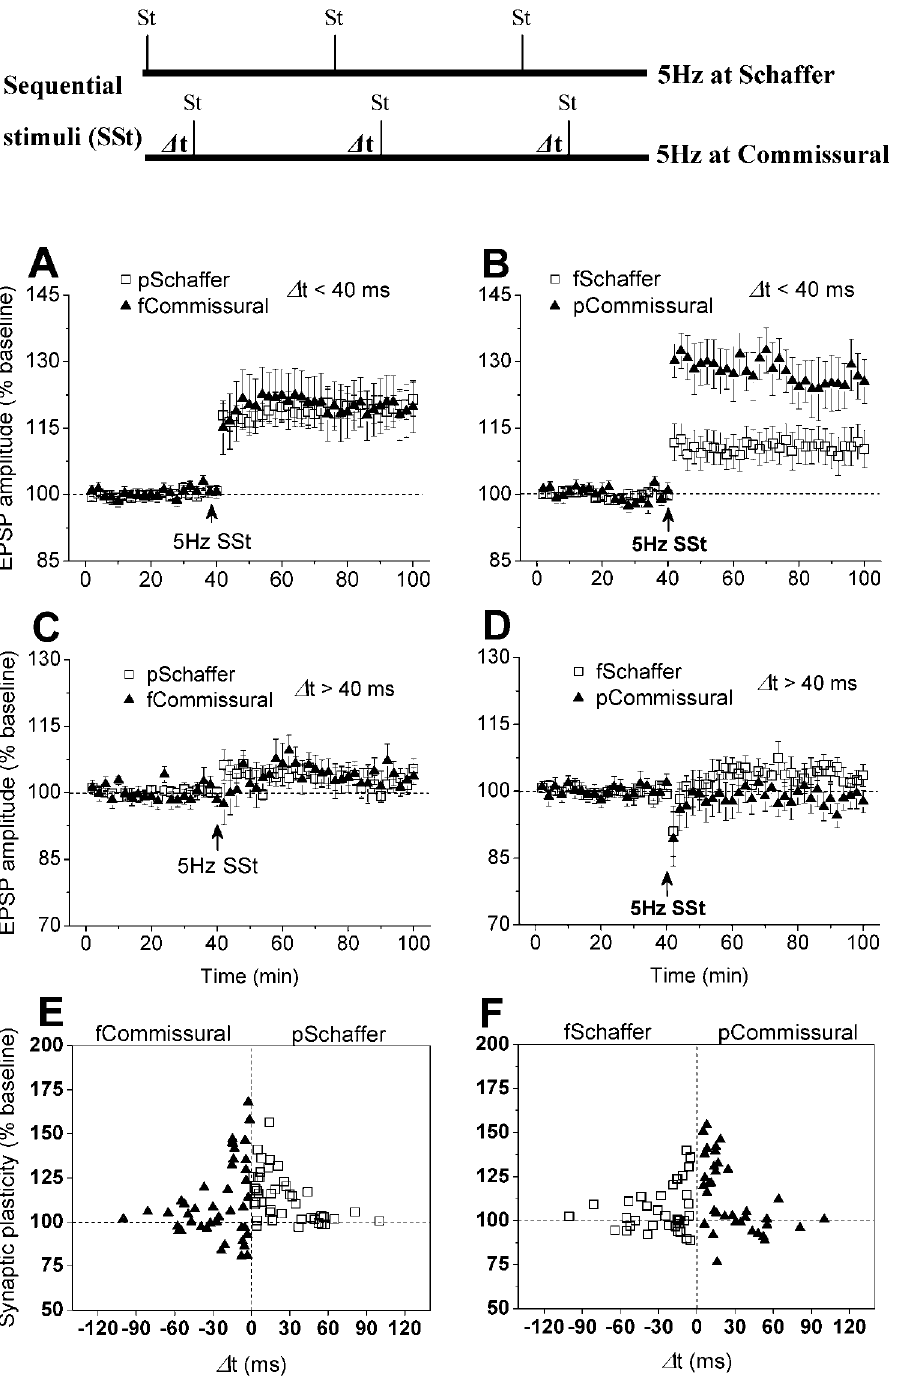
Figure 2. Coincident Schaffer/commissural activity induces LTP in both pathways in pentobarbital-anesthetized rats. A , Sequential stimulation (600 pulses, 5 Hz for 2 min) to Schaffer preceding to commissural pathway within a timing window of 40 ms induced LTP in both pathways (n=23; pSchaffer: 119.3 6 5.8%; fCommissural: 120.3 6 3.2%; P , 0.001 vs. baseline of pSchaffer or fCommissural; P=0.476 pSchaffer vs. fCommissural). p=preceding; f=following. B , When the activity sequence was reversed and within the timing window of 40 ms, the stimulation induced larger LTP in the commissural and smaller LTP in the Schaffer pathway (n=19; fSchaffer: 110.9 6 5.2%; pCommissural: 126.4 6 4.1%; P , 0.001 vs. baseline of fSchaffer or pCommissural; P=0.015 fSchaffer vs. pCommissural). C , The stimulation to Schaffer preceding to commissural pathway outside the 40-ms window ( D t=40 to 100 ms) failed to affect synaptic efficacy in either pathway (n=11; pSchaffer: 105.4 6 1.8%, P=0.065 vs. baseline; fCommissural: 103.7 6 2.2%; P=0.085 vs. baseline; P=0.338 pSchaffer vs. fCommissural). D , Similarly, the stimulation to Schaffer following to commissural pathway beyond the 40-ms window ( D t=40 to 100 ms) had no significant effect on synaptic efficacy in either pathway (n=10; fSchaffer: 102.4 6 2.9%, P=0.055 vs. baseline; pCommissural: 98.6 6 2.5%, P=0.091 vs. baseline; P=0.068 fSchaffer vs. pCommissural). E and F , Individual data confirmed the findings that the stimulation to Schaffer and commissural pathway by one preceding the other within about 40-ms timing window effectively evoked LTP in CA1 in the both pathways.